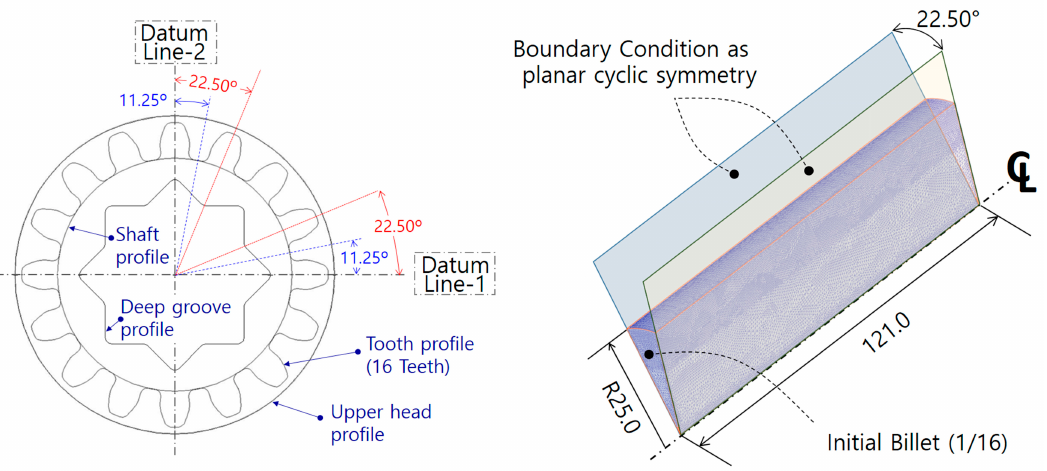
Figure 5. Geometric symmetricity and boundary conditions.